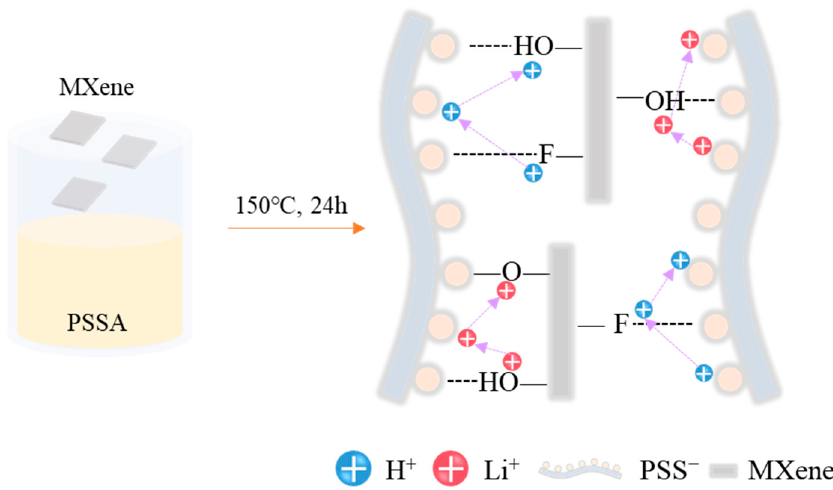
Figure 1. Schematic illustration of the fabrication of the poly(4-styrenesulfonic acid) crosslinked with MXene solution and proton conduction mechanism.